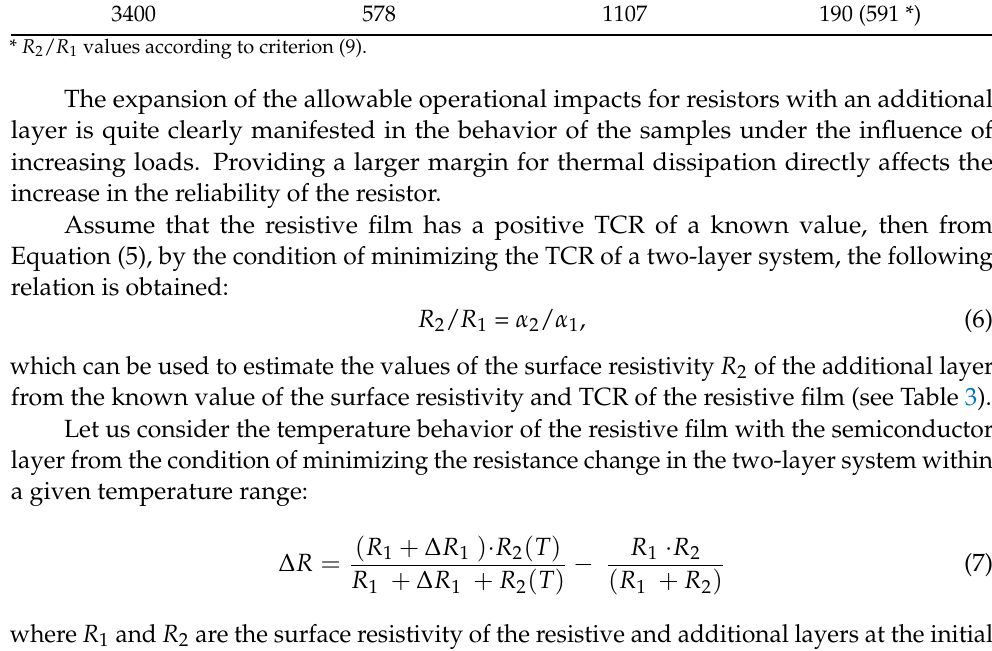
Table 3. Estimation of the resistance ratio of the resistive and additional semiconductor layers based on overheating temperatures of 400 and 500 ◦ C. R 2 /R 1 R 2 / R 1 R 2 /R 1 According to the B , K at Overheating at Overheating Criterion of TCR Temperature 400 ◦ C Temperature 500 ◦ C Minimization 2020 43 65 115 (226 *) 2400 89 141 135 (270 *) 3400 578 1107 190 (591 *) * R 2 / R 1 values according to criterion